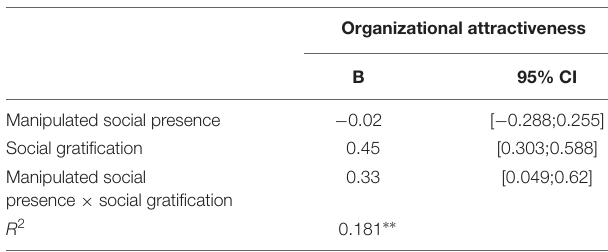
TABLE 5 | Results of Moderation Analysis Process Macro: Interaction Social Presence and Social